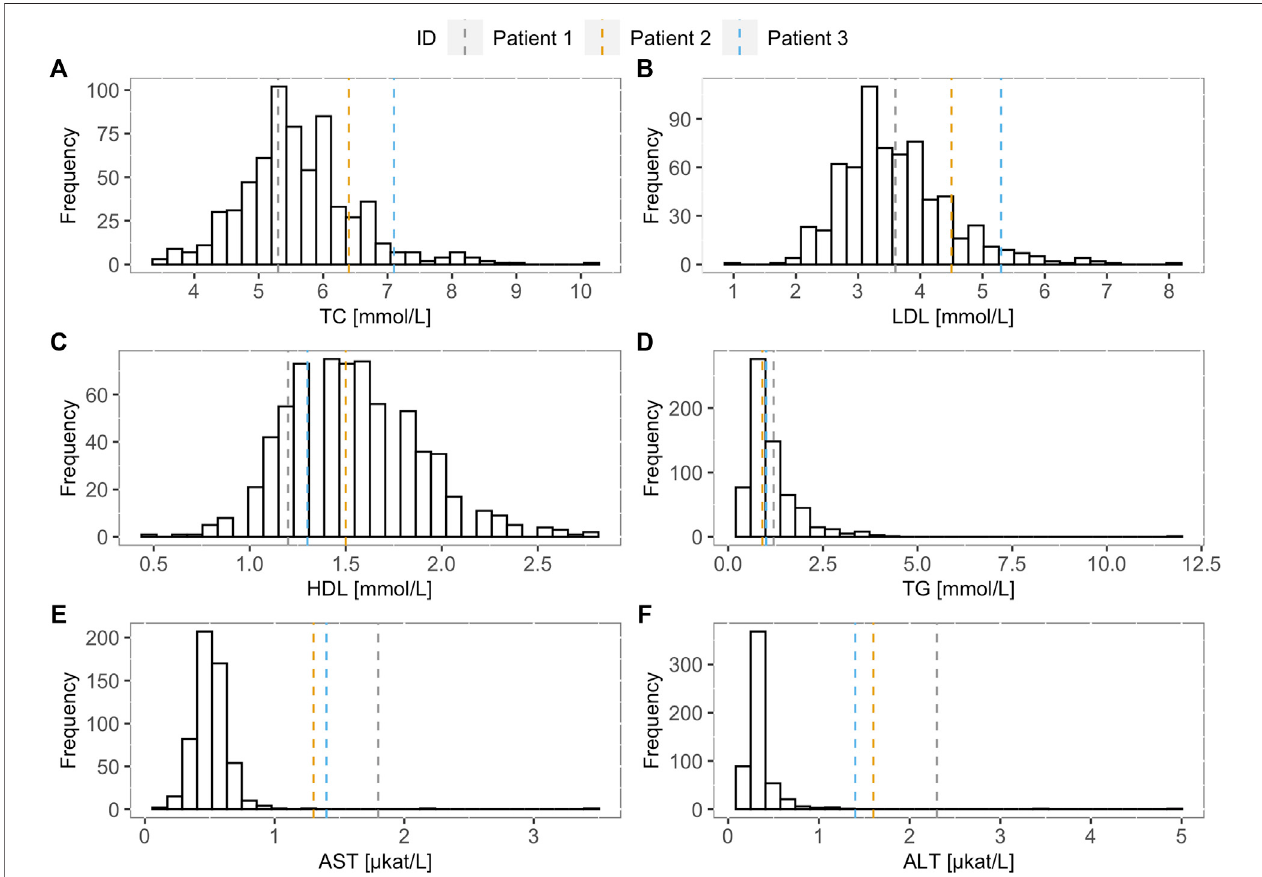
FIGURE1| LipoproteinandtransaminaselevelsoftheLAL-DpositivechildrencomparedtotheLAL-Dnegativecohort.Distributionof (A) totalcholesterol, (B) low- density lipoprotein cholesterol, (C) high-density lipoprotein cholesterol, (D) triglycerides, (E) aspartate transaminase, and (F) alanine transaminase for LAL-D negative population.Thevertical dottedlines showthevaluesofeach parameter fortheLAL-D-positivepatients.LDL-C:low-densitylipoproteincholesterol;TC:total cholesterol; HDL-C: high-density lipoprotein cholesterol; TG: triglycerides; AST: aspartate transaminase; ALT: alanine transaminase.